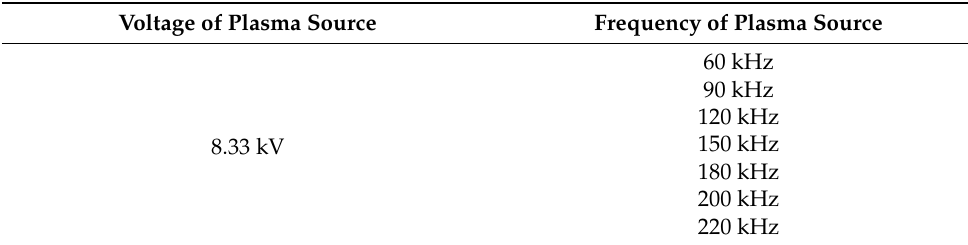
Table 3. Frequencies at which experiments were carried